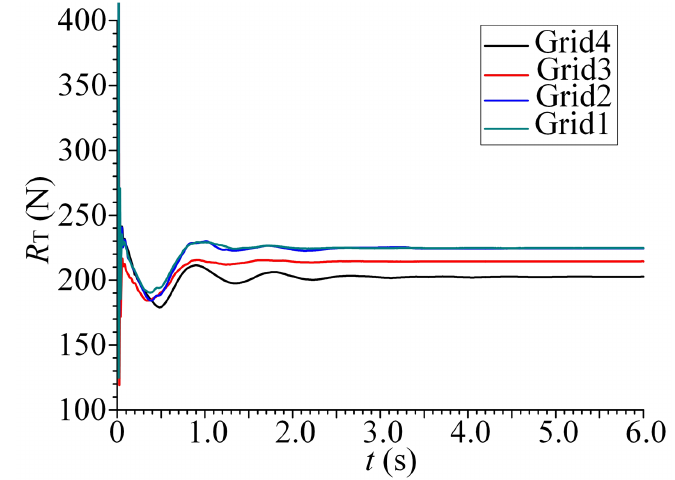
Figure 11. Resistance curves of the different grids.